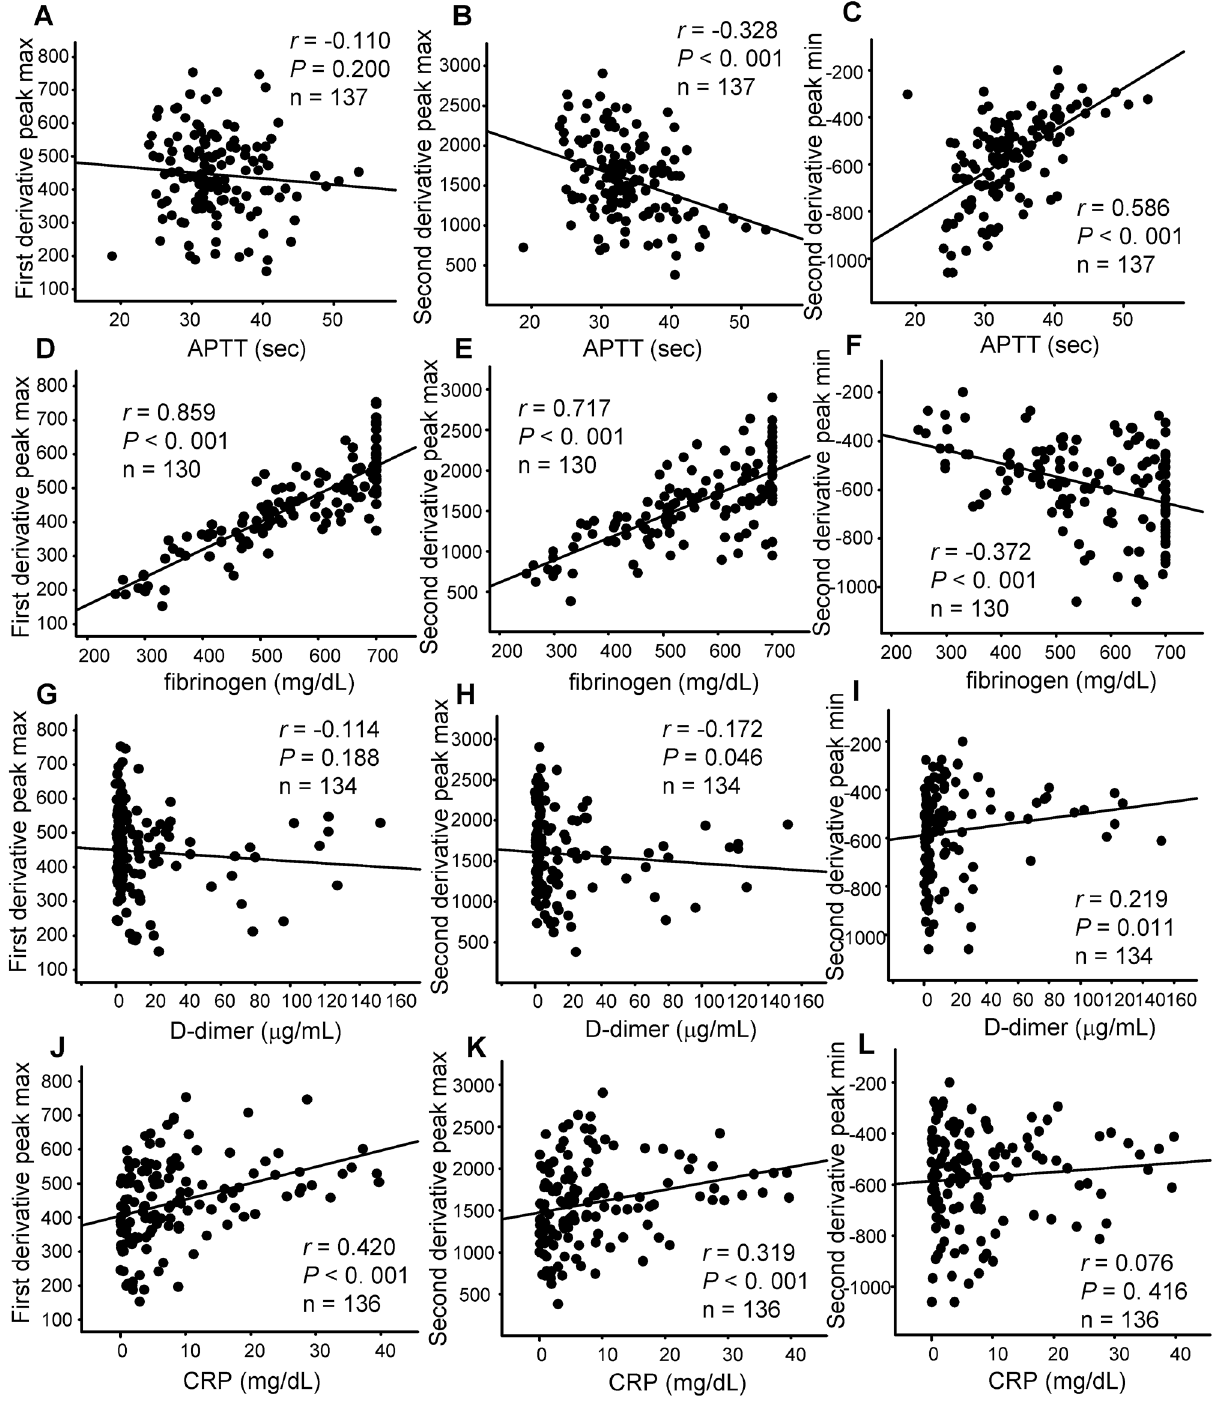
Figure 4. Correlations between parameters of APTT derivative curves and laboratory data related to coagulation in COVID-19 subjects. Correlations between the maximum first-derivative peak ( A , D , G , J ), the maximum second-derivative peak ( B , E , H , K ), and the minimum second-derivative peak ( C , F , I , L ) and APTT ( A – C ), fibrinogen ( D – F ), D-dimer ( G – I ), and CRP ( J – L